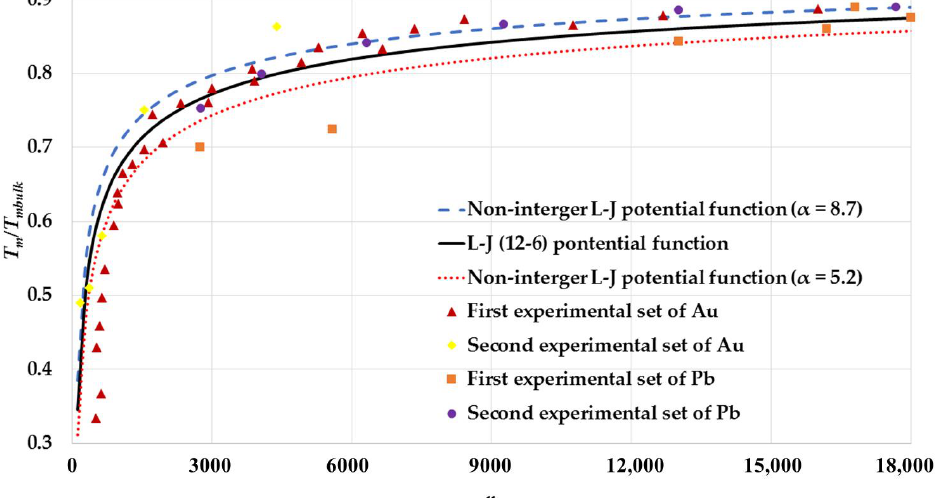
Figure 8. The variation of ratio T m / T mbulk as function of number of atoms n of spherical nanoparticles in an FCC struc- ture based on the non-integer L-J potential functions for different values of 𝛼 parameter and compared to two different experimental sets of Au nanoparticles: The first experimental set of Au [2] and the second experimental set of Au [5], and two different experimental sets of Pb nanoparticles: The first experimental set of Pb [6] and the second experimental set of Pb [7].